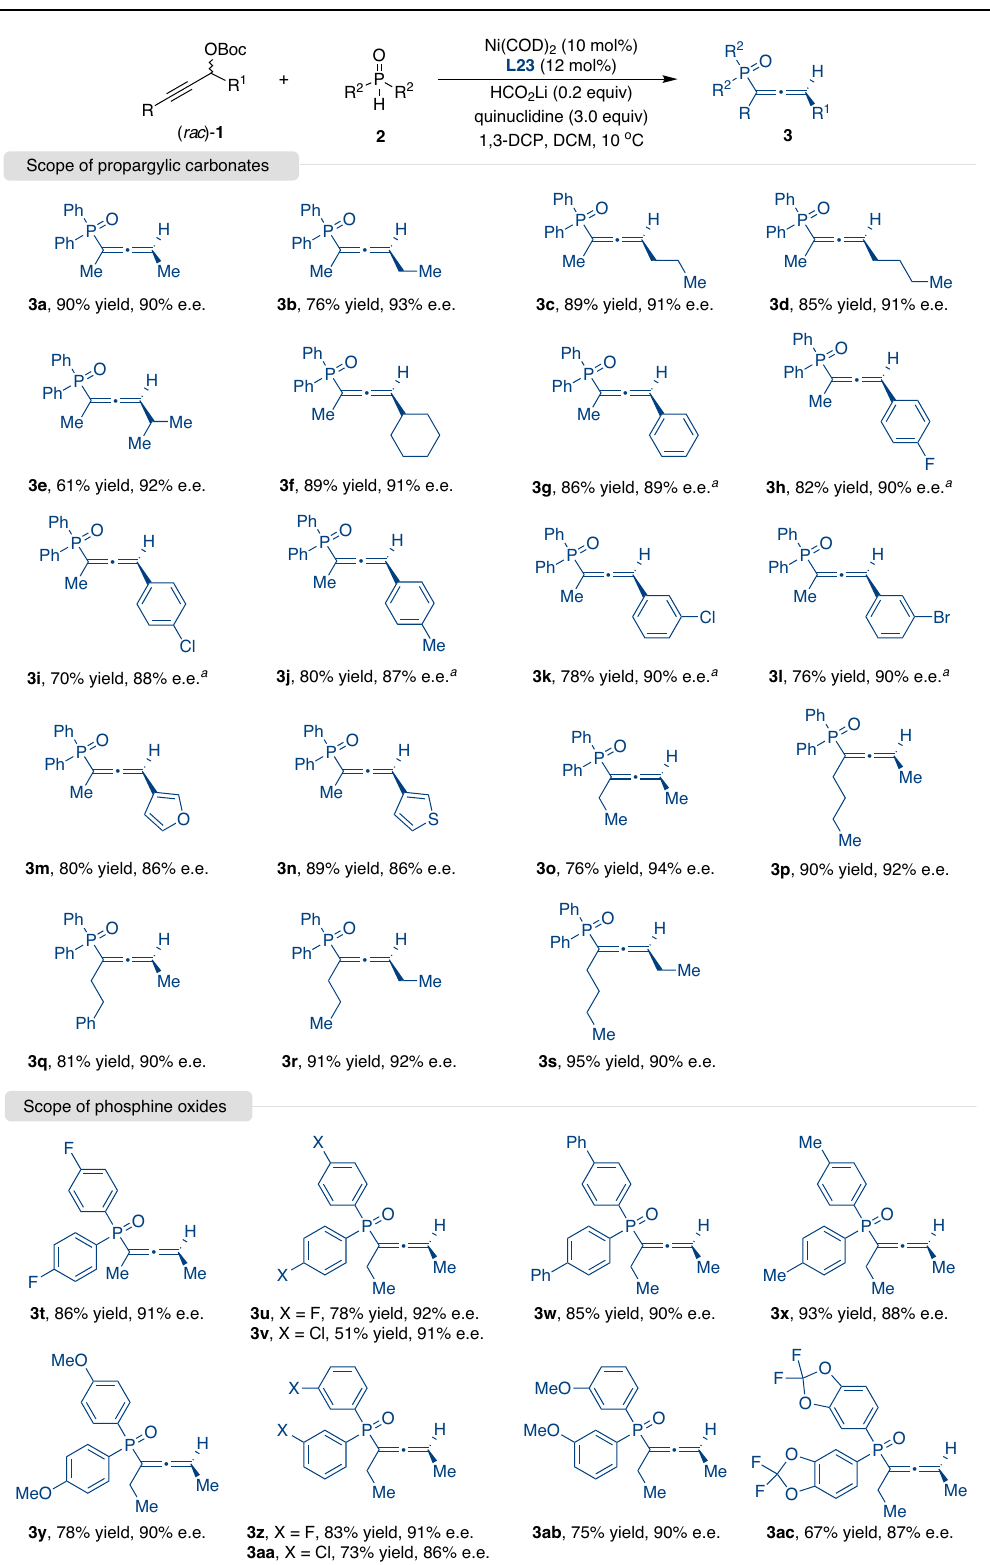
DCM (1mL) at 10°C. Isolated yields after chromatography are shown. e.e. values were determined by HPLC analysis. a Quinuclidine (5.0 equiv), without 1,3-DCP, 0°C.